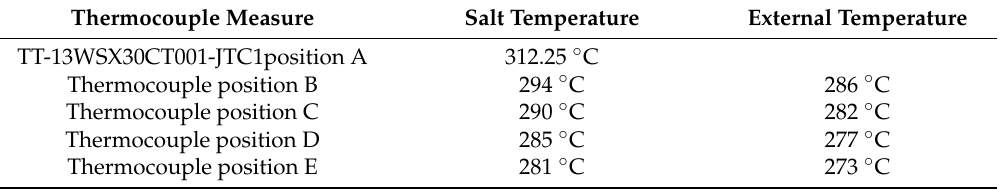
Figure 2. Cross section of the pipe and thermocouples position. Table 1. Temperature measurements in molten salt pipes of the solar plant “La Africana”.